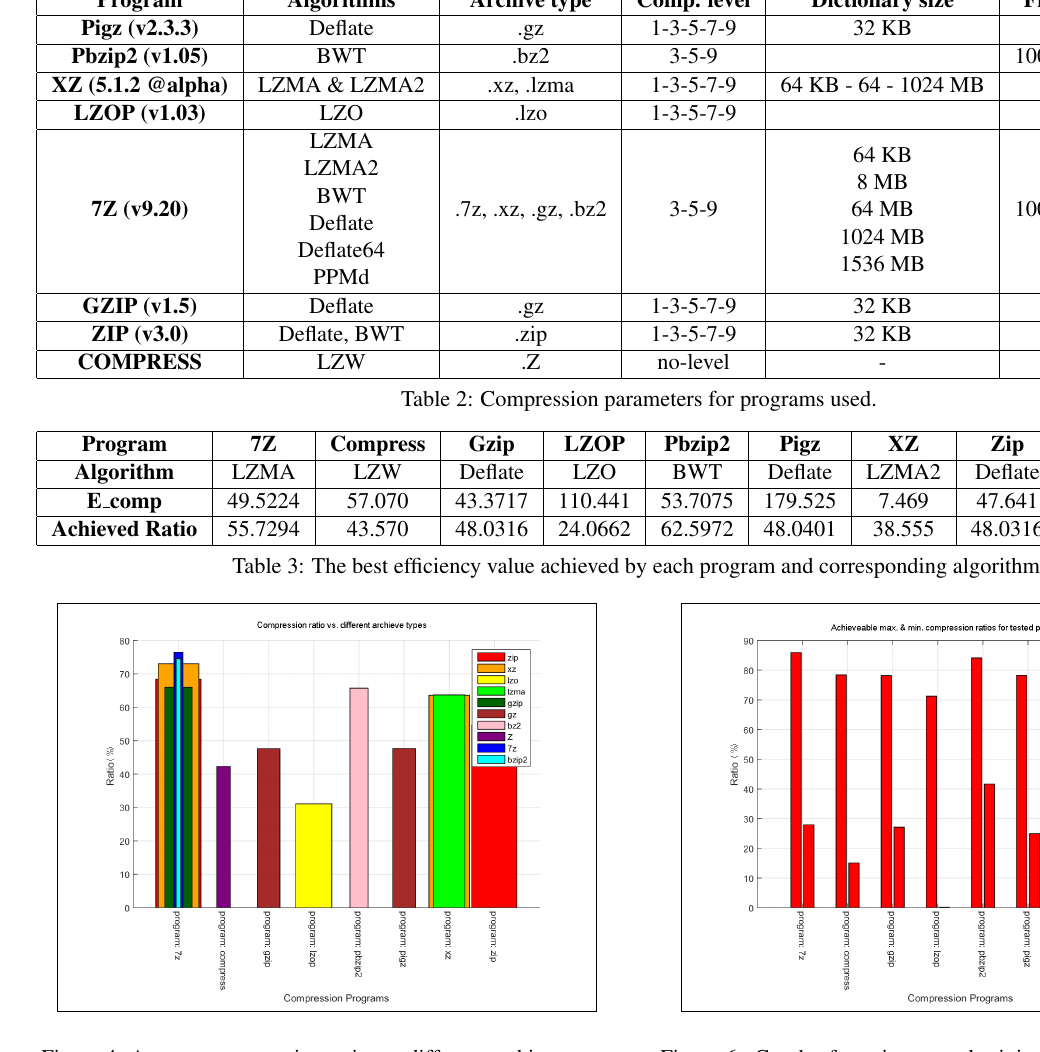
Figure 4: Average compression ratio vs. different archive types.